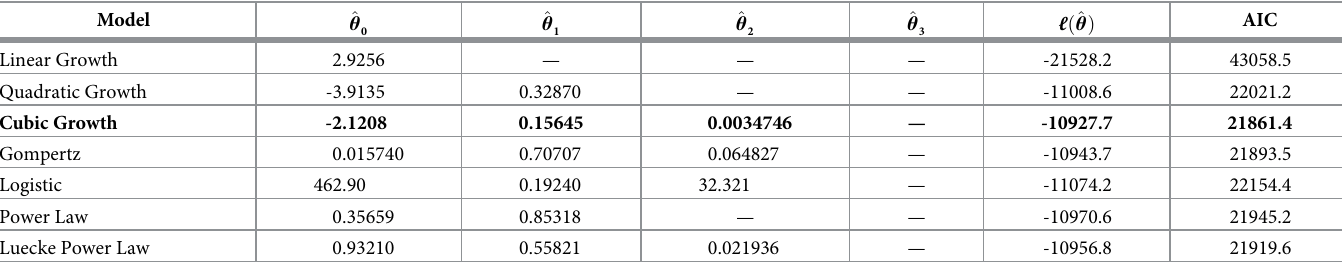
Table 18. Fetal brain mass models (g vs. fetal mass in g for power law models, g vs. gestational age in weeks for all other